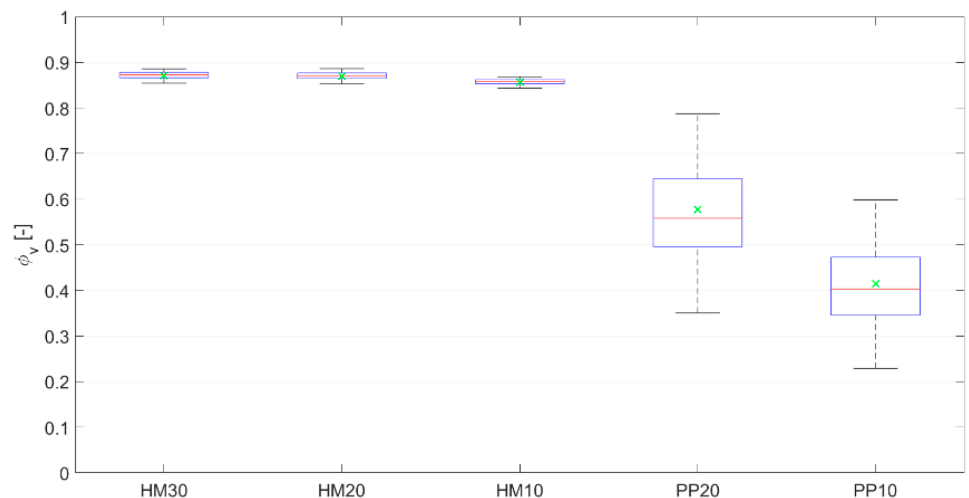
Figure 5. Boxplot of outflow reduction efficiency. In each box, the upper and lower edges indicate the first and third quartile, respectively, the red central line is the median and the green x symbol is the mean. The whiskers length was set equal to the interquartile distance. Outliers have been hidden.